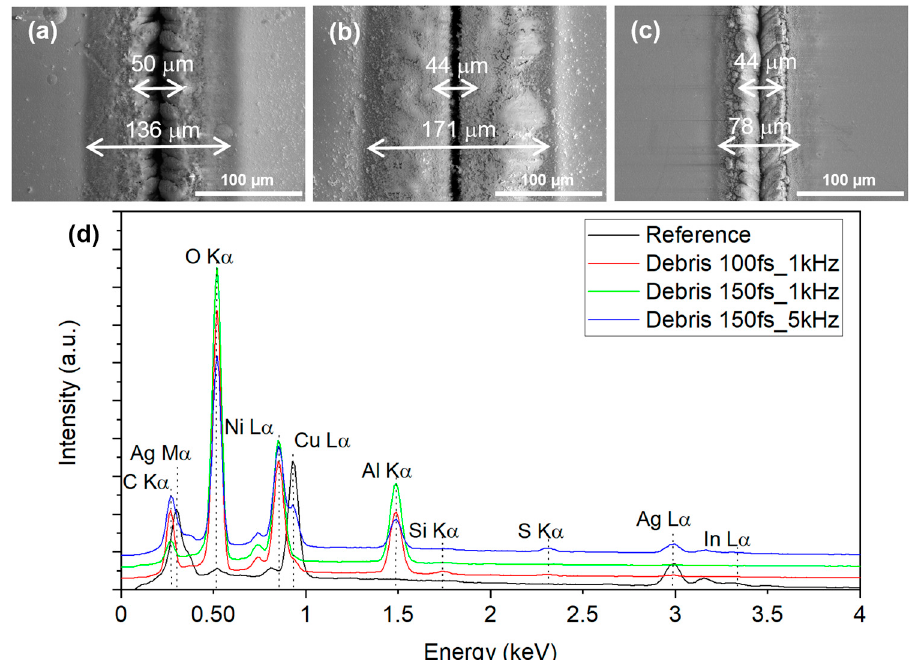
Figure 2. Top-view SEM micrographs of single lines cut by DLW for the di ff erent samples (laser entry side): ( a ) 100fs_1kHz; ( b ) 150fs_1kHz; ( c ) 150fs_5kHz. The spot sizes and the total extension of debris are highlighted. ( d ) EDS spectra of the debris and the unstructured reference sample. Curves are o ff set by a fi xed amount to improve visibility.